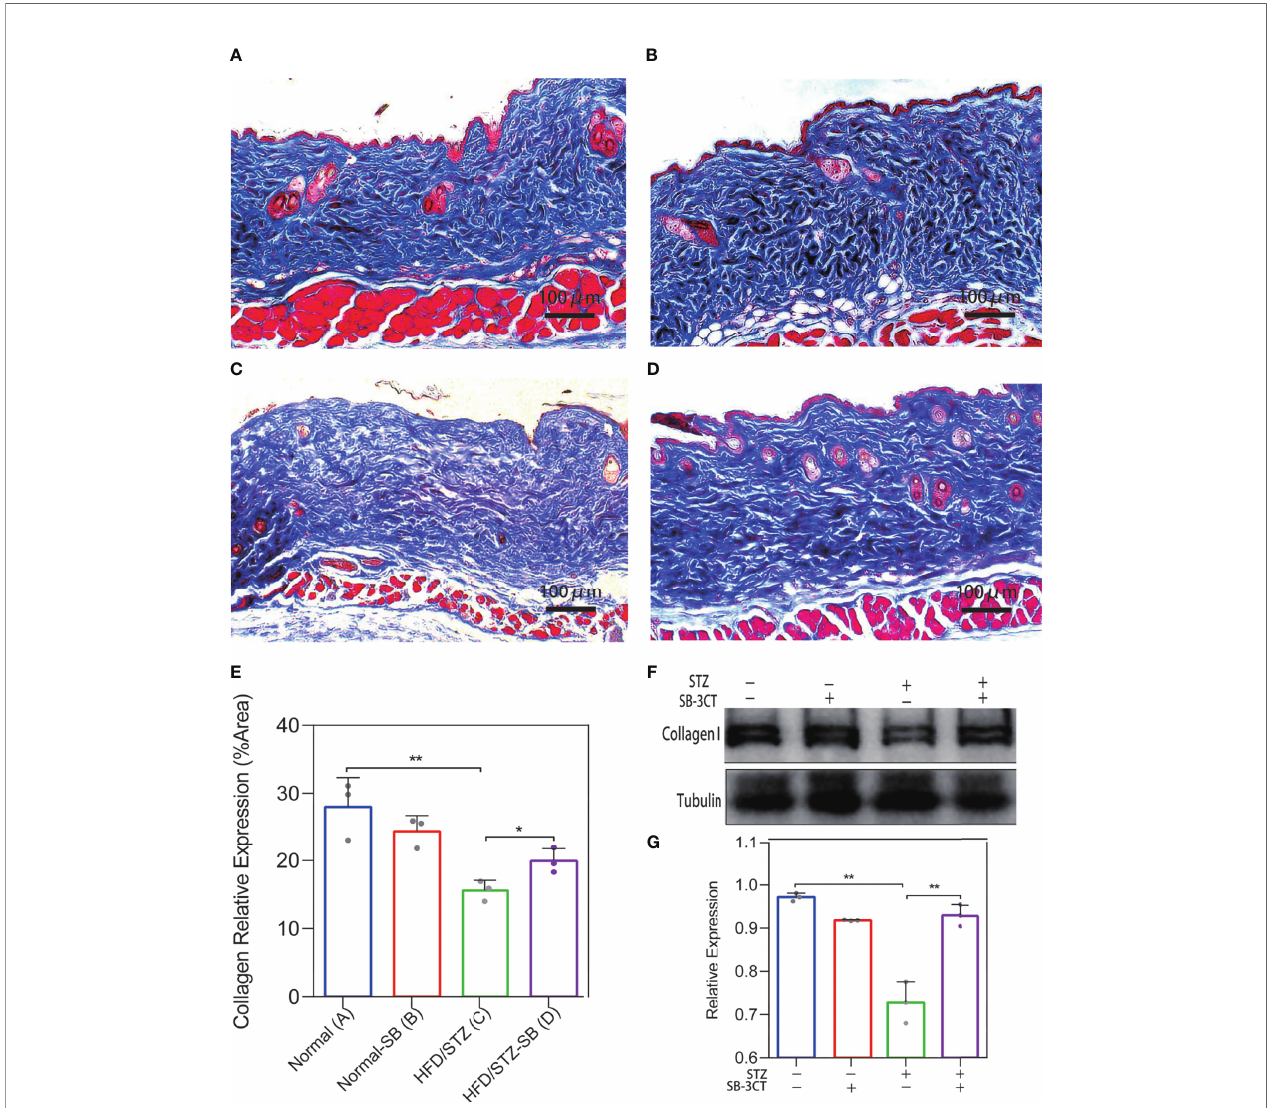
FIGURE 6 | Changes in collagen deposition of STZ-induced diabetic mouse skin with the inhibitor (SB-3CT) of MMP-2 and MMP-9. (A – D) Representative Masson ’ s trichrome stain of skin in the Normal ( n = 7), Normal-SB ( n = 6), HDF/STZ-DMSO ( n = 5), and HDF/STZ-SB groups ( n = 5). (E) The quantitative analysis of collagen stain. (F, G) Western blot and their quantitative analysis of collagen I expression in skin of different mice. (Normal group: normal diet with solvent DMSO; Normal-SB group: normal diet with SB-3CT; HDF/STZ-DMSO group: high-fat diet combined with STZ followed by DMSO solvent; HDF/STZ-SB group: high-fat diet combined with STZ followed by SB-3CT.). The results are provided as the means ± SEM, *p < 0.05 and **p < 0.01 compared with the